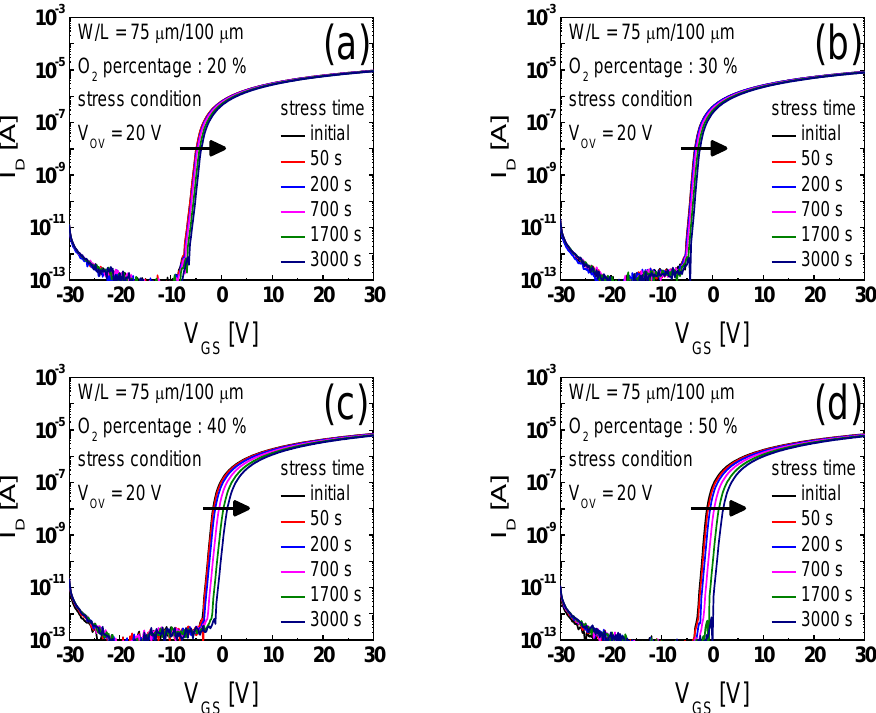
Figure 3. Time evolutions of the transfer curves under constant V OV of 20 V measured from the IGTO TFTs prepared at oxygen contents of ( a ) 20%, ( b ) 30%, ( c ) 40%, and ( d ) 50% in the sputtering ambient.